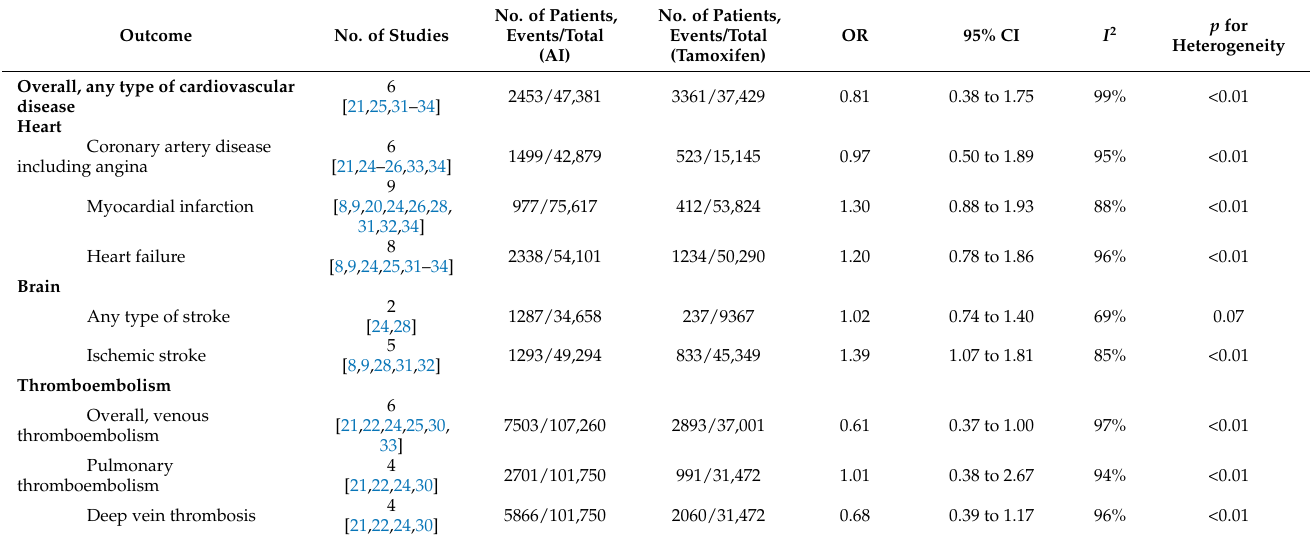
Figure 2. Prevalence of overall cardiovascular outcomes in patients with AI. Table 3. Comparison of various cardiovascular outcomes between AI and